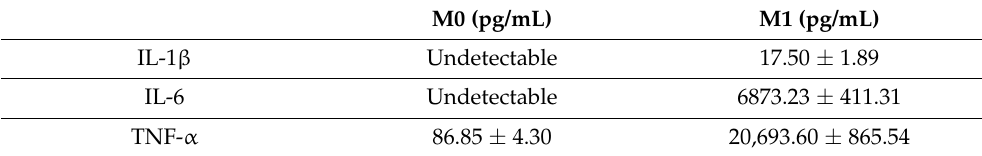
Table 1. Inflammatory cytokine secretion by undifferentiated (M0) and M1 macrophages ( n = 6). M0 (pg/mL) M1 (pg/mL) IL-1 β Undetectable 17.50 ± 1.89 IL-6 Undetectable 6873.23 ± 411.31 TNF- α 86.85 ± 4.30 20,693.60 ±